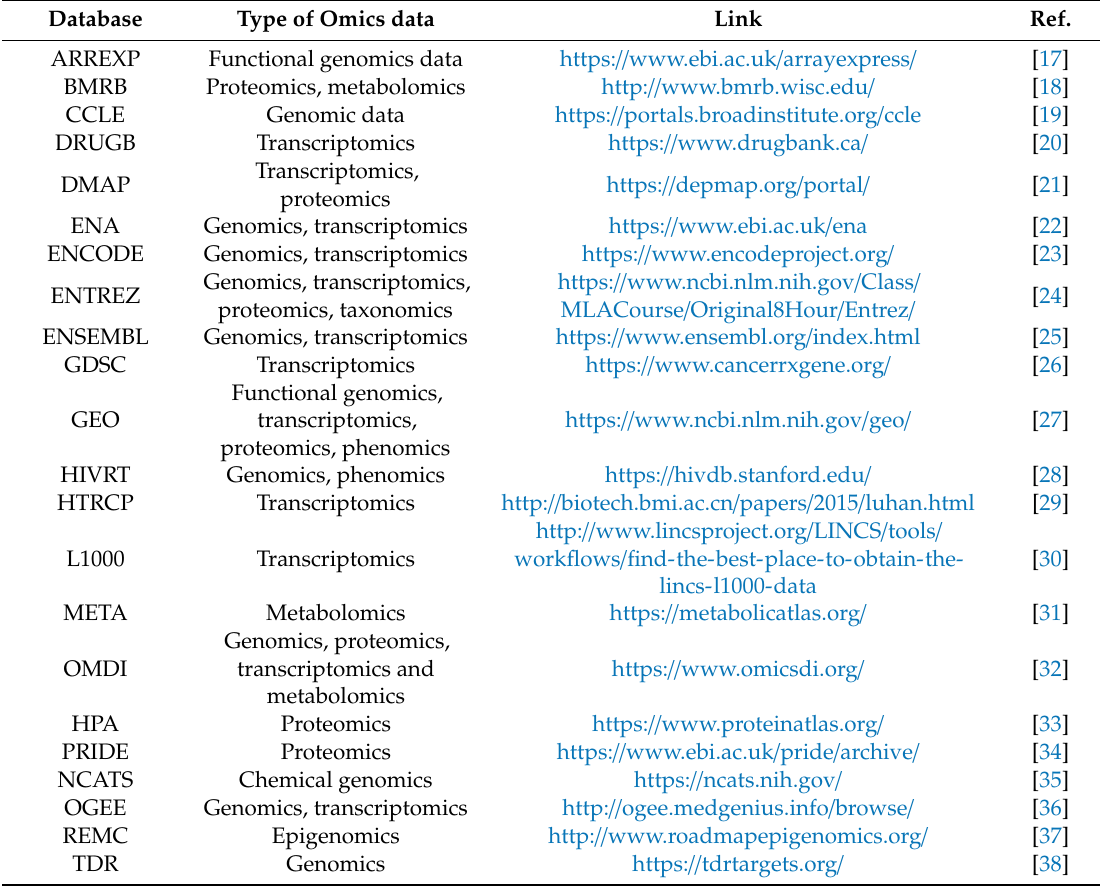
Table 1. DBs and their associated omic data as useful resources for drug